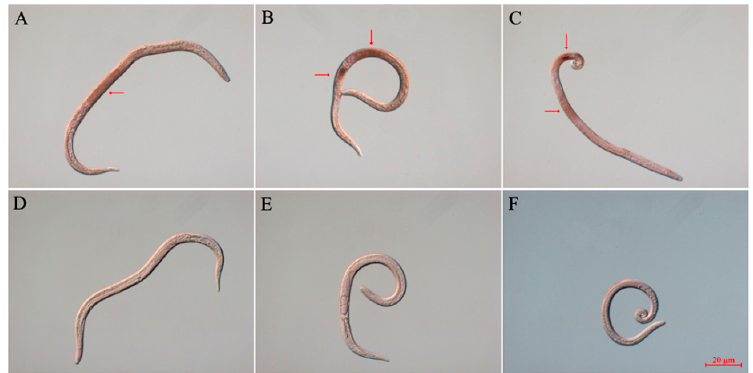
Figure 3. Localizations of Bx-cpl s mRNA by in situ hybridization (ISH). Bx-cpl was expressed in PWNs in the intestine of females ( A ); the intestine and egg of females ( B ); and the intestine and seminal vesicle of males ( C ). The control groups showed no signals ( D – F ). The red arrows point to the hybridization signals. The scale bars are 20 µm.